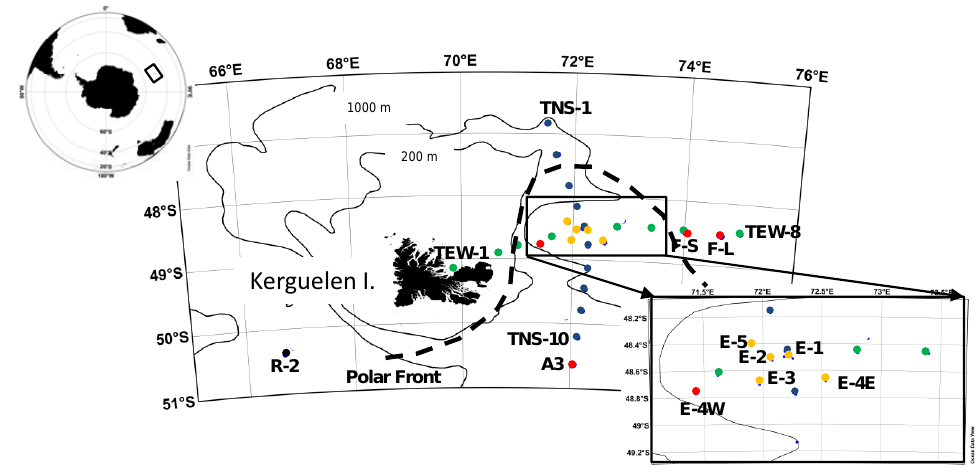
Figure 1. Map of the KEOPS2 study area. The locations of the stations are marked by colored dots. Blue indicates the stations of the north– south transect (TNS), green indicates the stations of the east–west transect (TEW), orange indicates the stations E located in the meander of the polar front (zoom panel). Red shows other stations located in the fertilized region and black shows the station located in the high-nitrate low-chlorophyll (HNLC) region. Detailed positions of the stations are given in Table